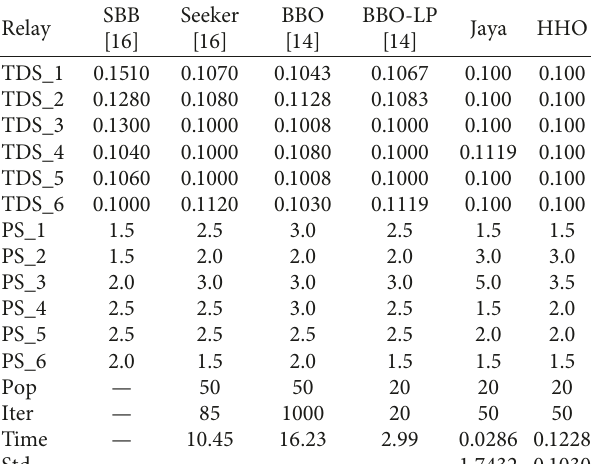
Table 6: Time dial setting and plug setting for the 3-bus system by MINLP formulation.